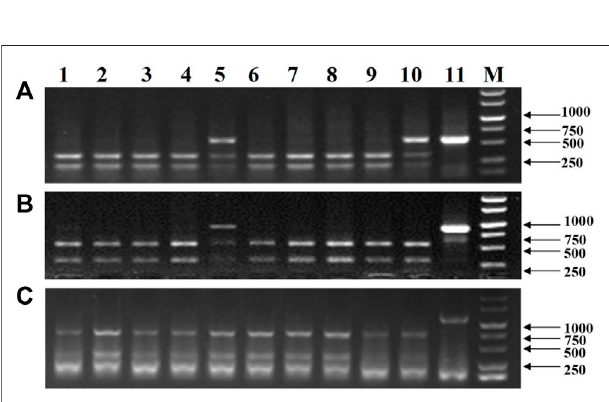
FIGURE5| Detectionofmutationsofthewheat TaNud genesindifferent tillers of WL15 by PCR-RE. (A) TaNud - 7A . (B) TaNud - 7B . (C) TaNud - 7D . 1 – 10: different tillers of WL15; 11: positive control; M: DNA marker.